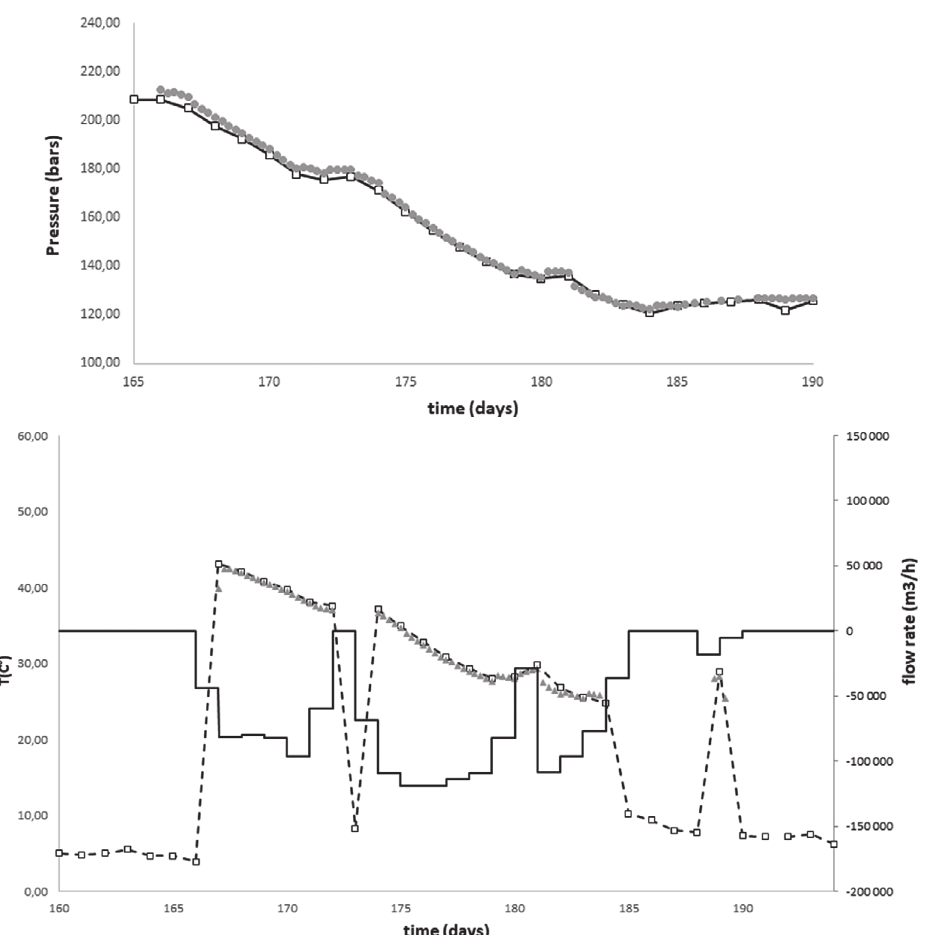
Fig. 5. Well-head pressure and temperature – available data (grey marks) – estimated by model (black marks) – fl ow rate (black line) is imposed in the model.